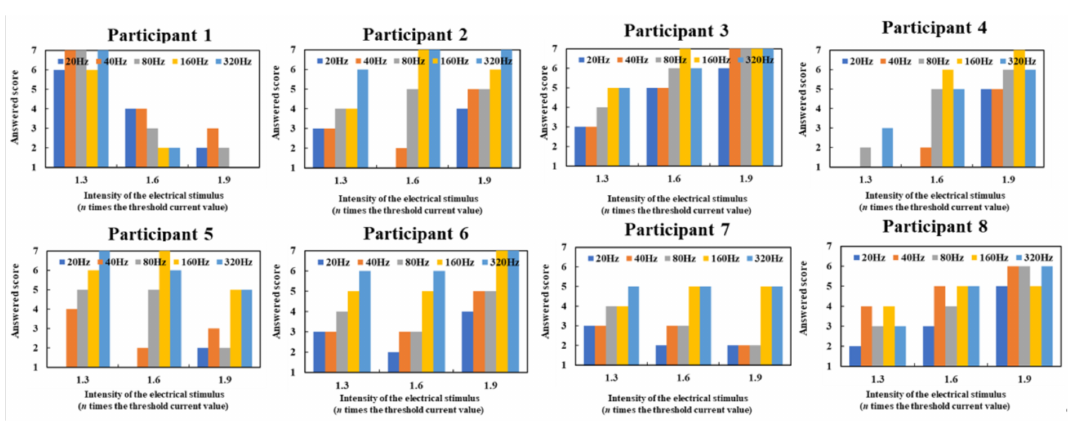
Figure A1. Score of electrical stimulus for each subject.